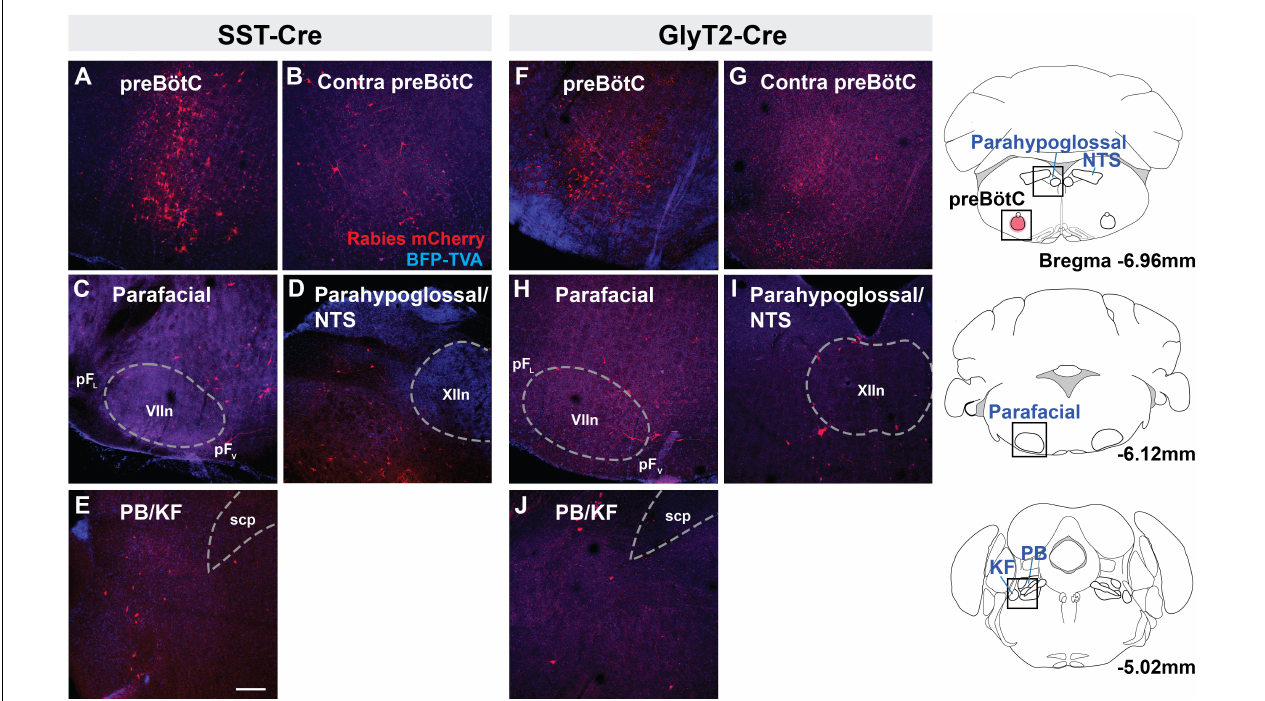
FIGURE 2 | Brainstem afferent projections of SST + and GlyT2 + preBötC neurons. Projections of SST + neurons extend to the contralateral preBötC, ventral (pF V ) and lateral (pF L ) parafacial nuclei, parahypoglossal/NTS, and parabrachial/Kölliker-Fuse (PB/KF) nuclei (A–E) . GlyT2 + preBötC projections extend to the same regions (F–J) . Location of each image indicated as boxes in the schematics to the right; preBötC injection site in red. (scp, superior cerebellar peduncle; VII, facial nucleus; and XIIn, hypoglossal nucleus), Scale bar = 200 µ m.